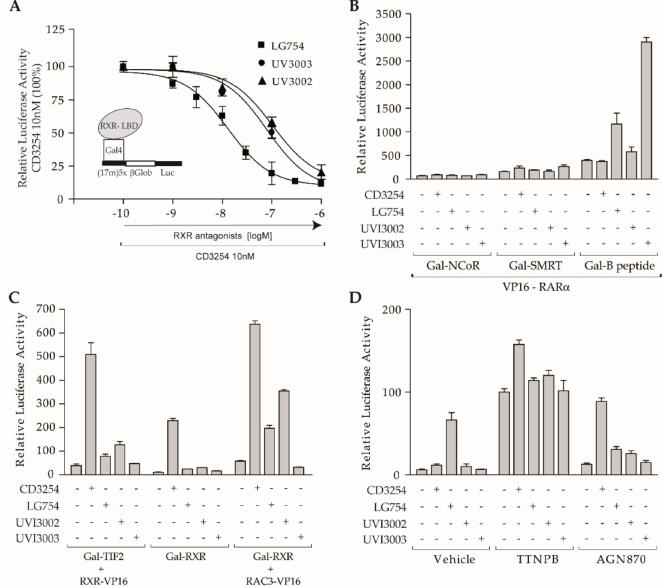
Figure 5. Contribution of di ff erent classes of rexinoids in the RXR-RAR α heterodimer activity. ( A ) To assess antagonistic activities of synthetic rexinoids, COS cells were co-transfected with (17m)5x- β Glob-Luc and Gal-RXR expression vector. The reporter was activated by 10 nM CD3254 (100%) and increasing concentrations of LG754 (closed squares) or UVI3002 (closed triangles) or UVI3003 (closed circles) were added in a concentration range of 10 − 10 to 10 − 6 M, as indicated; ( B ) mammalian two-hybrid assays with (17m)5x- β Glob-Luc and VP16-RXR and Gal-NCoR (left panel) or Gal-SMRT (middle panel) or Gal-B peptide were performed in COS cells to assess the influence of indicated retinoids on interaction between RXR and CoRs. Compounds were used at 1 µ M; ( C ) mammalian two-hybrid assays with (17m)5x- β Glob-Luc and Gal-TIF2 and VP16-RXR (left panel) or with Gal-RXR and RAC3-VP16 (right panel) were performed in COS cells to assess the influence of indicated retinoids on interaction between RXR and TIF2 and to reveal the partial agonist activity of RXR antagonists. Transactivation assay with Gal-RXR used alone is shown in the middle panel. Compounds were used at 1 µ M; ( D ) transactivation assays in MRLN cells to assess the activity of the indicated rexinoids on RXR-RAR α activity when used alone or in association with either TTNPB or AGN870 (100%, TTNPB induced activity). Compounds were used at 1 µ M. Error bars,